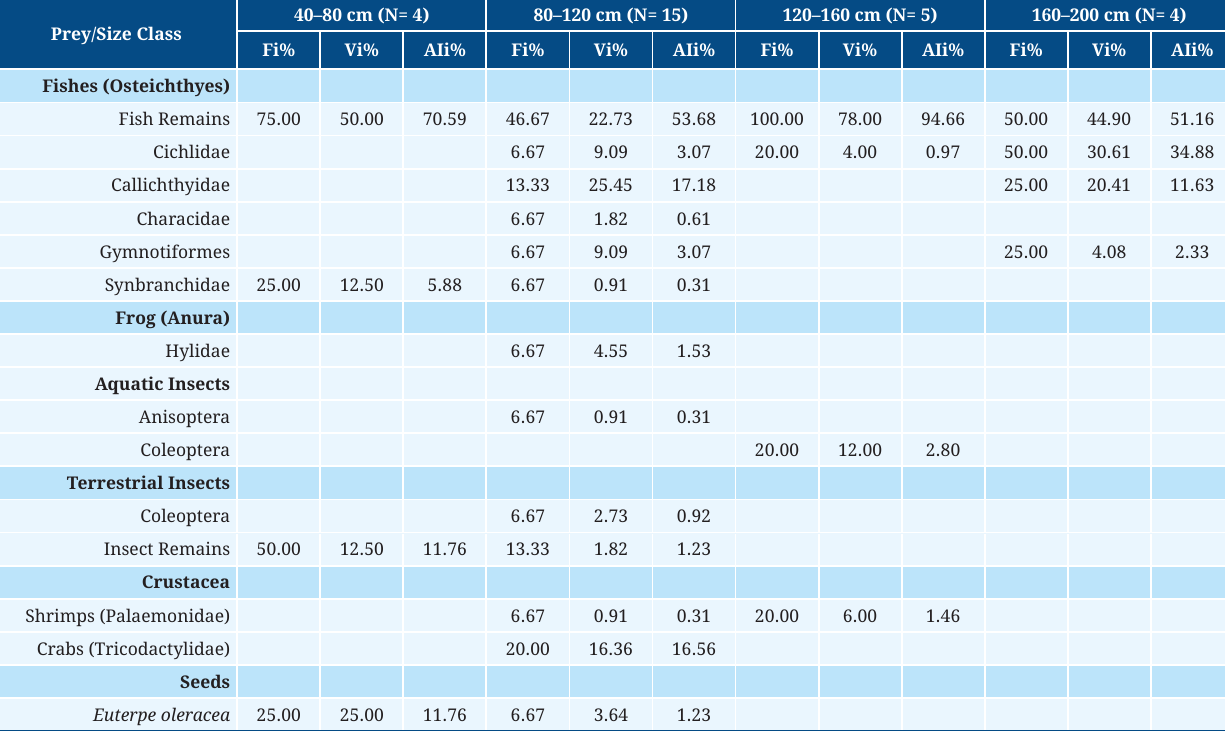
TABLE 2 | Preys consumed by size class of Electrophorus varii in the Curiaú River EPA, state of Amapá, Brazil. Fi% = Frequency of Occurrence, Vi% = Volume and AIi% = Alimentary